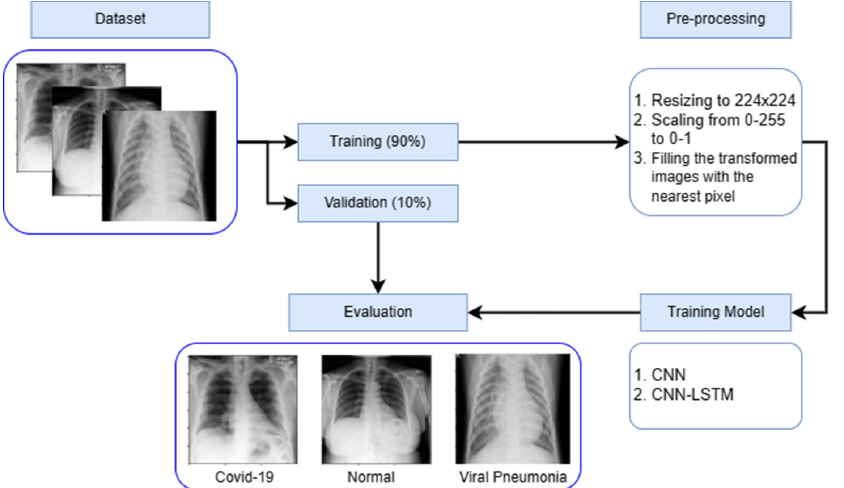
Fig. 5. Schema of model